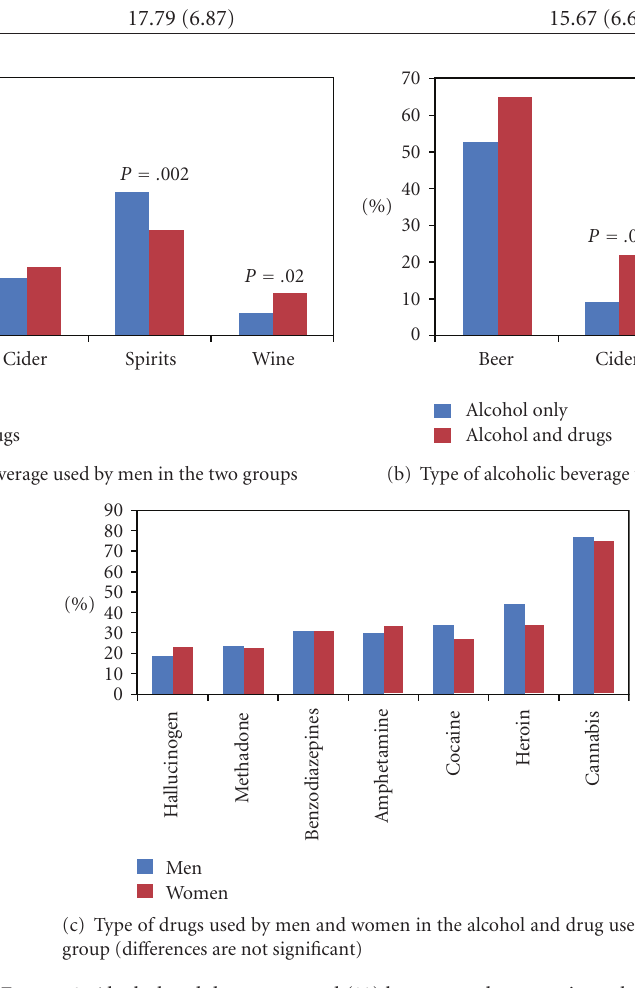
Figure 2: Alcohol and drug type used (%) by men and women in each